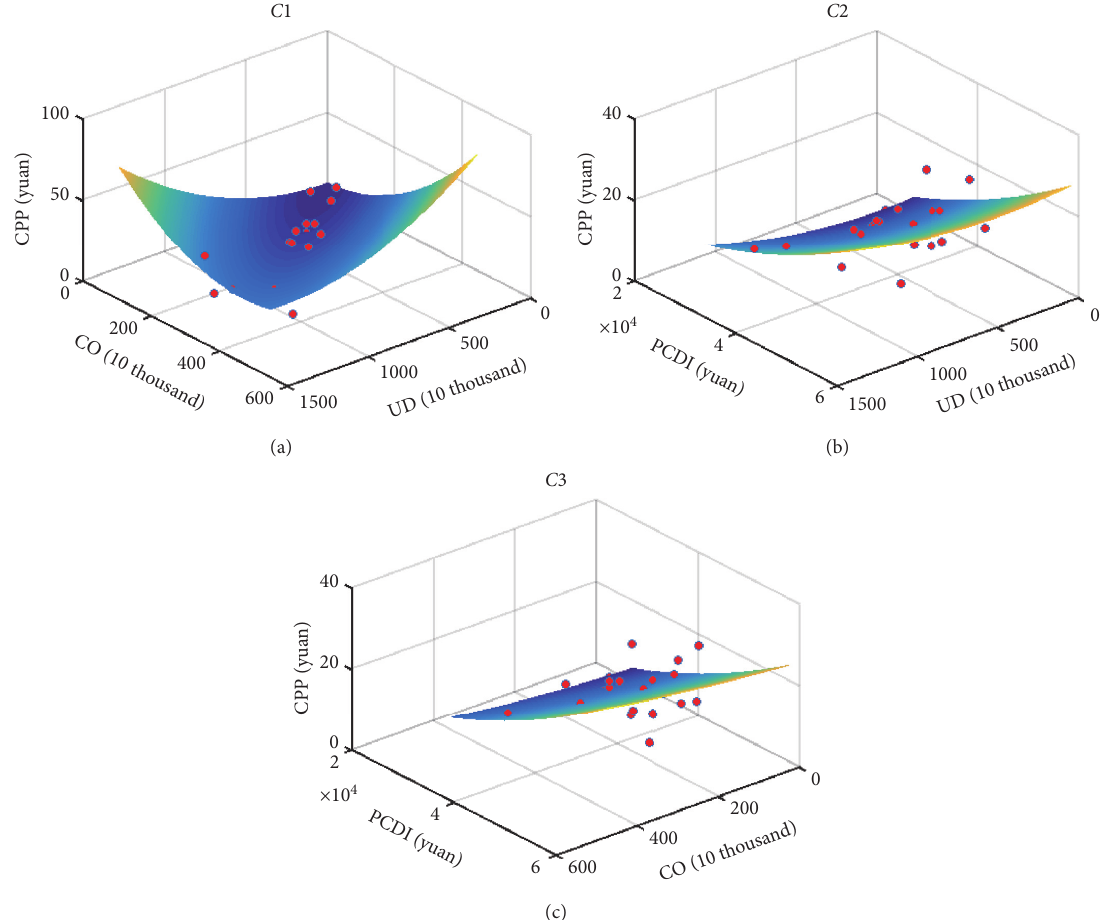
Figure 3: 3D data visualization for touristed cities: (a) the effect among CPP-UD-CO, (b) the effect among CPP-UD-PCDI, and (c) the effect among CPP-